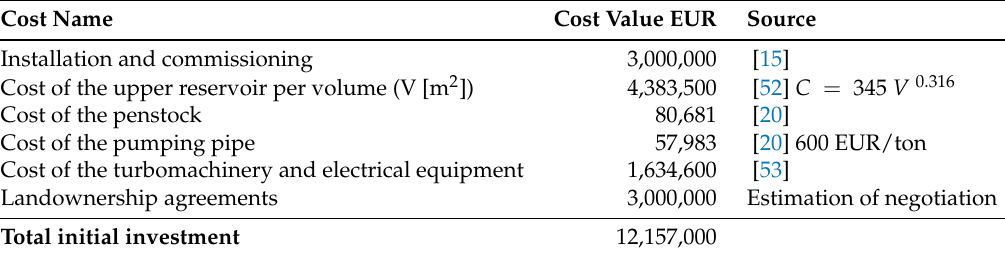
Table 3. Breakdown of the total initial investment cost expressed in